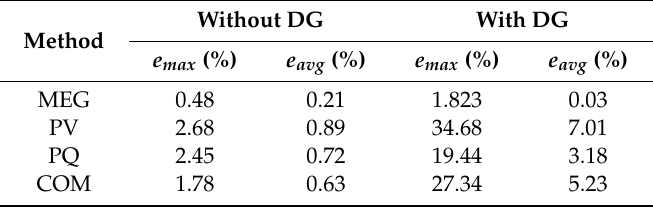
Table 3. Equivalent errors of four models with DG and without DG.